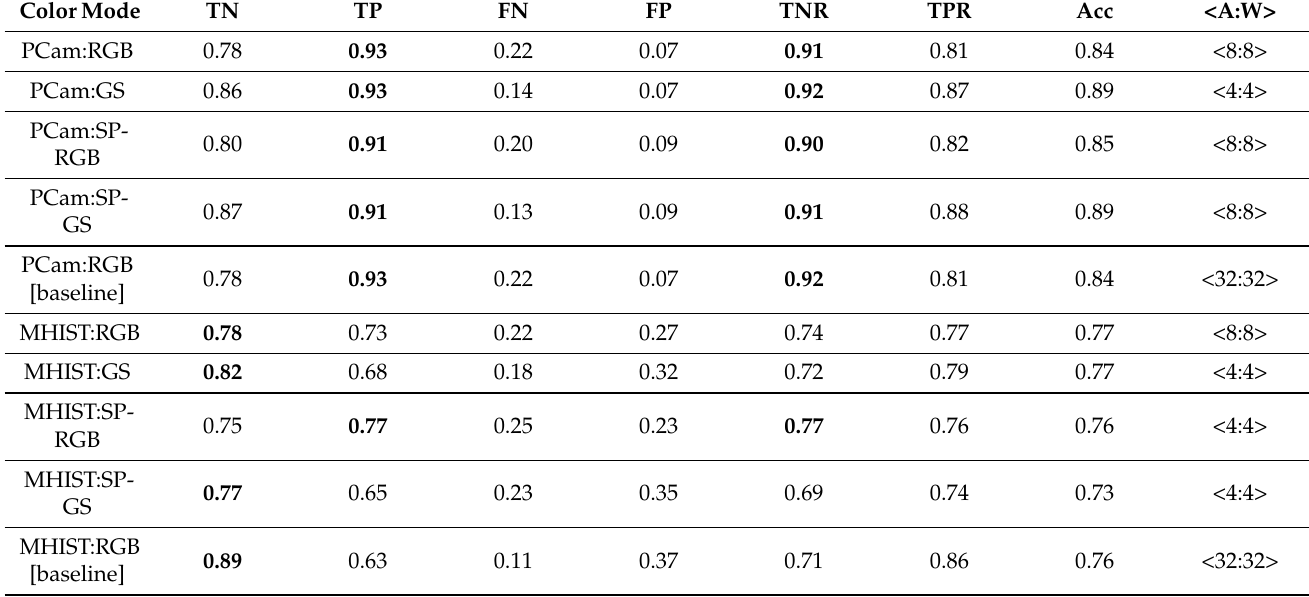
Table 6. Detailed results of the best configurations for each color mode: True positive (TP), true negative (TN), false positive (FP), false negative (FN), true positive rate (TPR), true negative rate (TNR), and accuracy. The Activation (A) and Weights (W) bit-width are shown. To have a fair comparison, the baseline method contains no quantization or further optimization. All results are normalized to the predicted